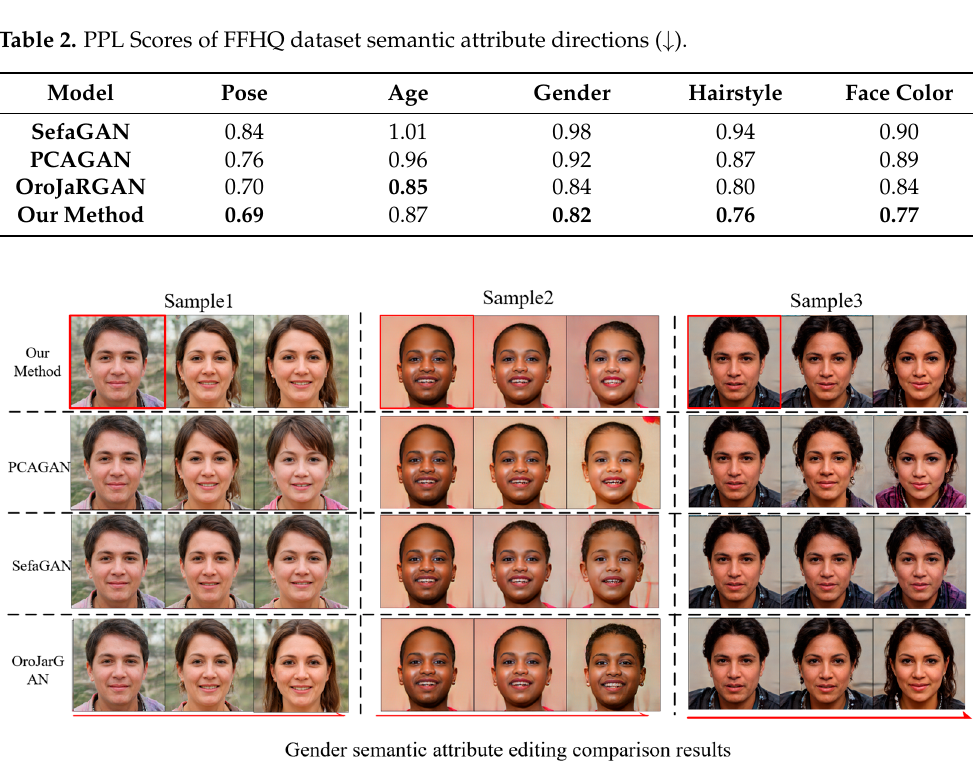
Figure 10. FFHQ dataset faces gender semantic attribute editing comparison results.